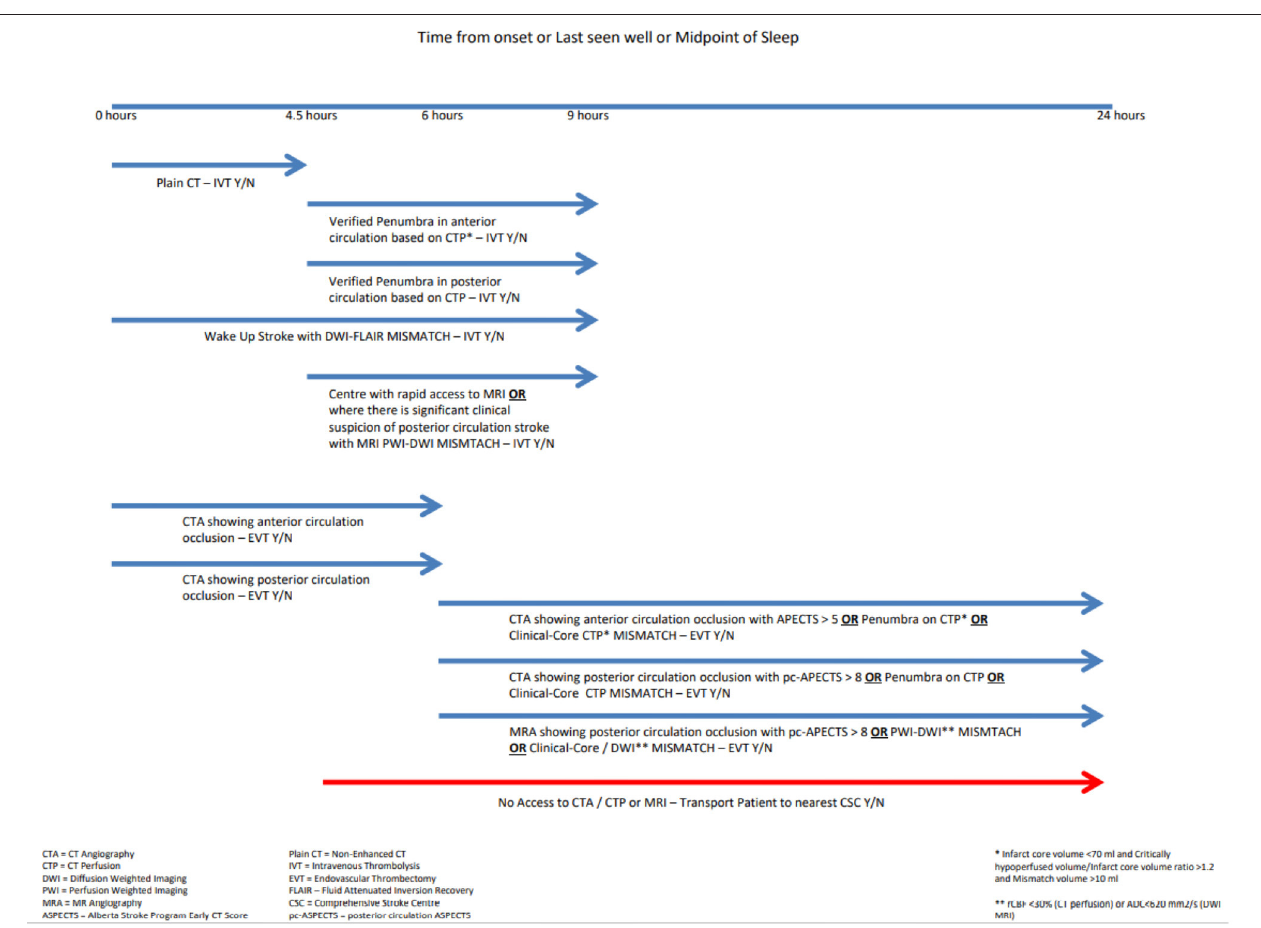
FIGURE 3 | Flow chart for reperfusion decision